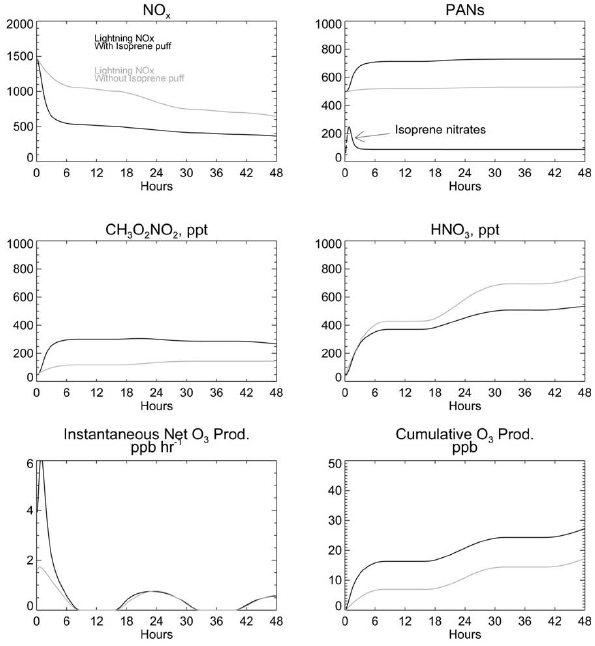
Fig. 9. Langrangian model simulation for the expected chemical evolution for key nitrogen containing species injection of 1ppbv isoprene in the high NO x (LNO x )